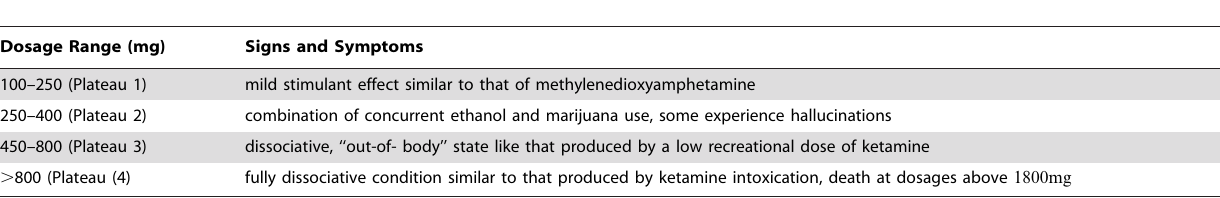
Table 1. Signs and symptoms associated with dextromethorphan ingestions.